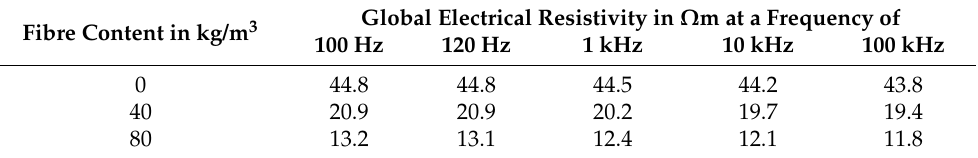
Table A42. Results of the resistivity measurements of the concrete mixture 32-60-300-00 after storage in Ca(OH) 2 for 14 days for the investigations of possible leaching effects.